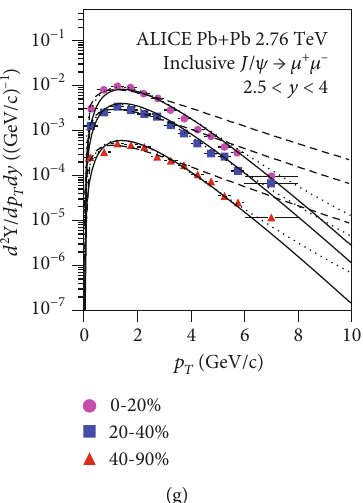
Þ d 2 N / dp dy , (d, e) ð 1/2 π p Þ d 2 σ / dp dy , (f) d 2 σ / dp dy , and (g) d 2 Y / dp dy of J / ψ in T T T T T T